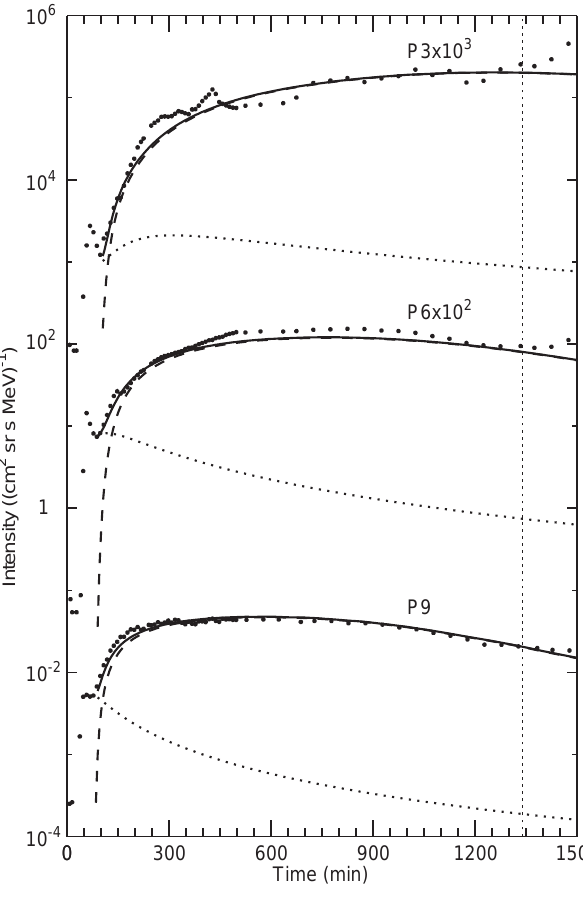
Fig. 2. Observed (GOES-6, filled circles ) and calculated pre-shock count rates of the 19 October 1989 SEP event in proton channels P3, P6 and P9 corresponding to the nominal energy ranges 8.7–14.5 MeV, 84–200 MeV and 430–505 MeV, respectively (a detailed description of the secondary channels is given in Table 3). The calculated prompt component is marked by the dotted line , the delayed component by the dashed line and their sum by the solid line . The vertical dotted line shows the